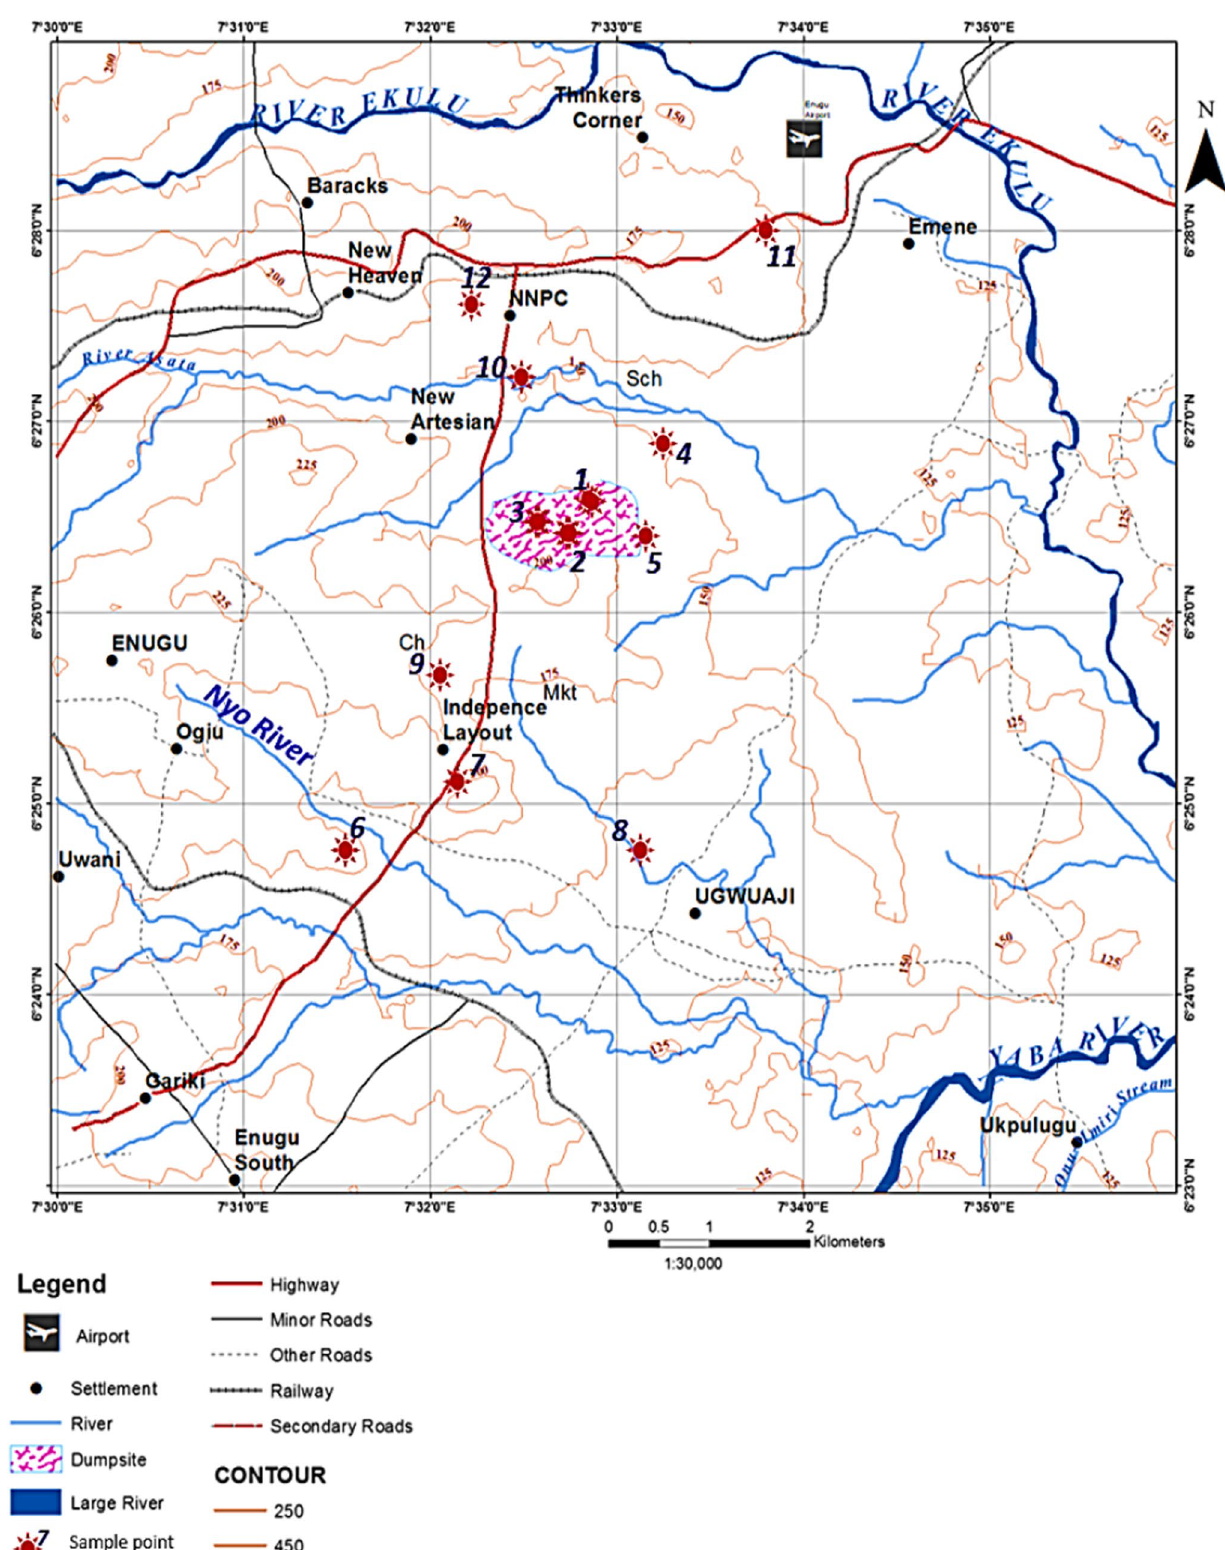
Fig. 2 Accessibility and drainage map of the study